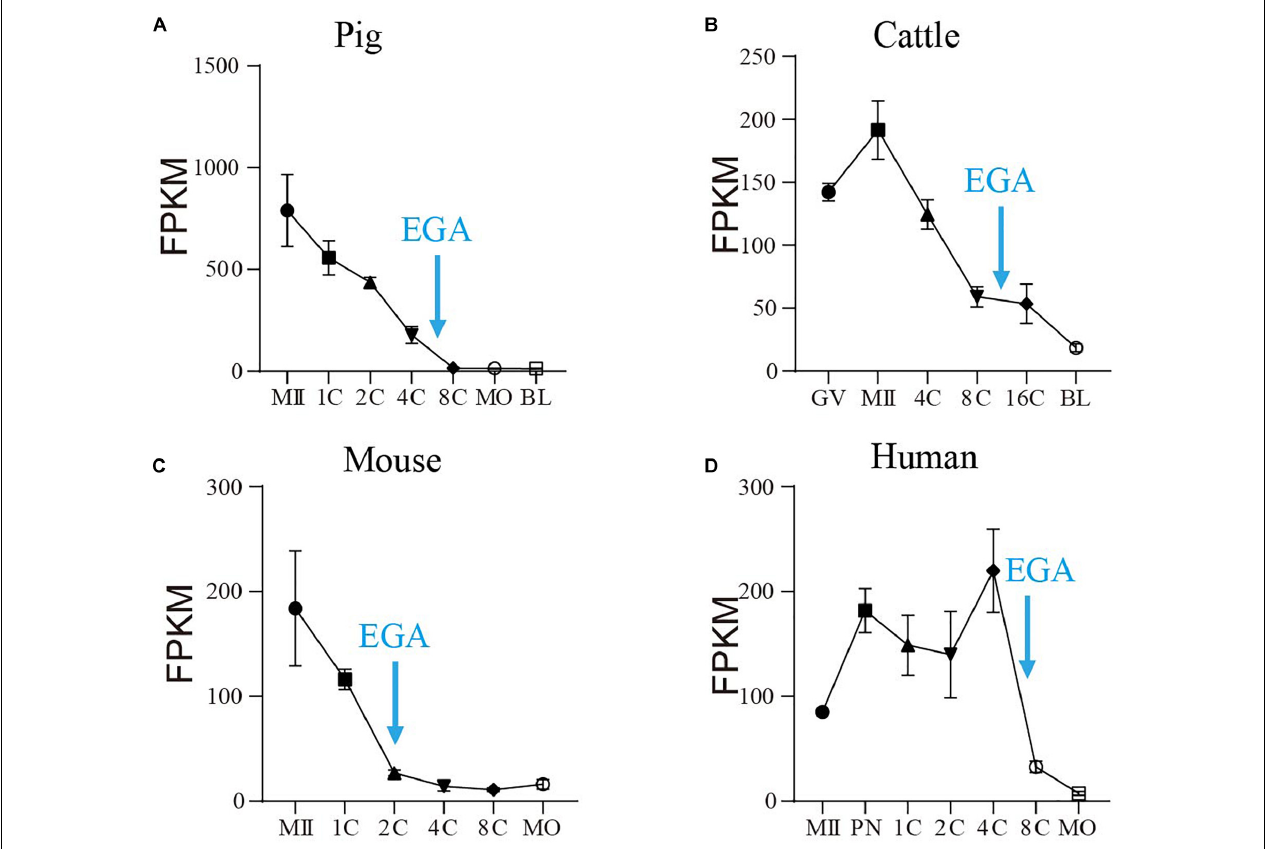
FIGURE 1 | The mRNA profile of SIN3A during oocyte maturation and early embryonic development in pigs, cattle, mice, and humans. (A) Pig. (B) Cattle. (C) Mice. (D) Human. All the SIN3A mRNA expression data in different species were collected from published databases. GV, germinal vesicle; MII, metaphase II; PN, pronucleus; 1C, one-cell; 2C, two-cell; 4C, four-cell; 8C, eight-cell; 16C: 16-cell; MO, morula; BL, blastocysts. The blue arrow indicates the time of embryonic genome activation (EGA) for each